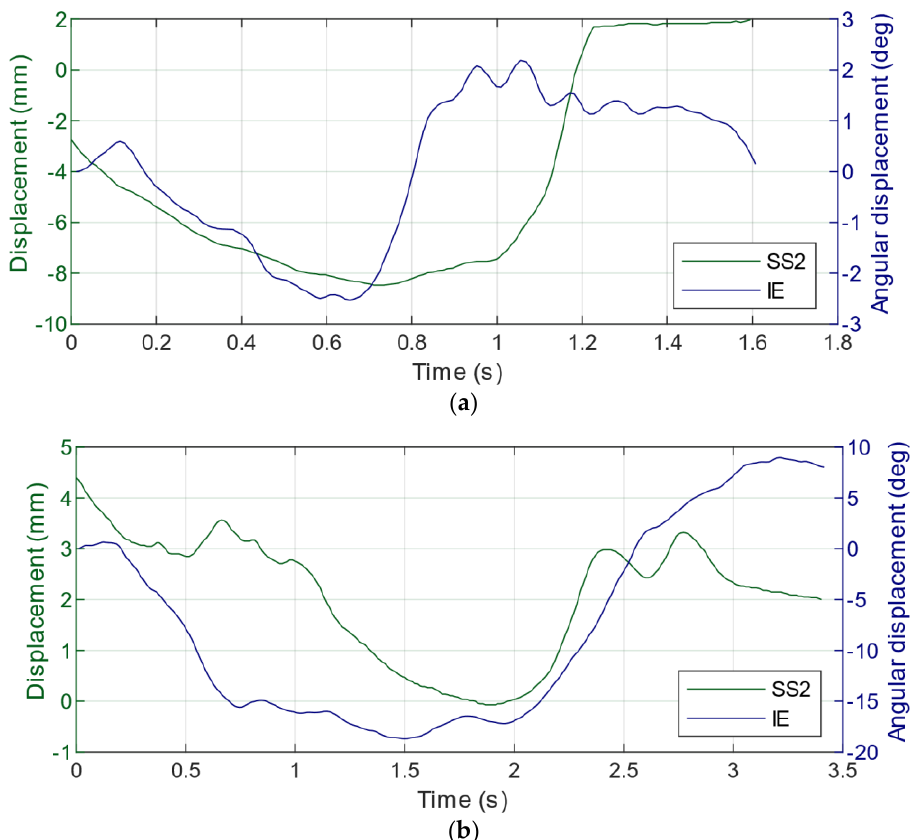
Figure 9. Stretch Sensor 2 displacement (green) and IE angular displacement (blue) collected through the smart brace from healthy ( a ) and injured ACL ( b ) during pivot shift test.